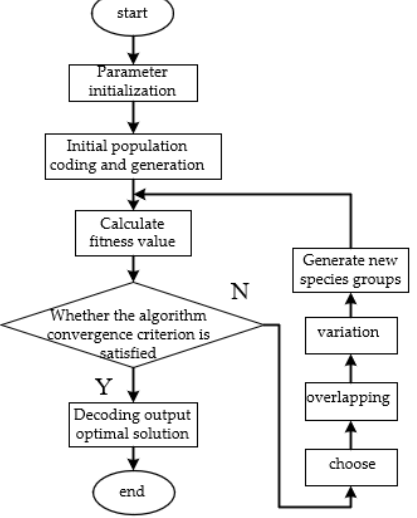
Figure 12. Flow chart of PID parameter self-tuning based on GA.